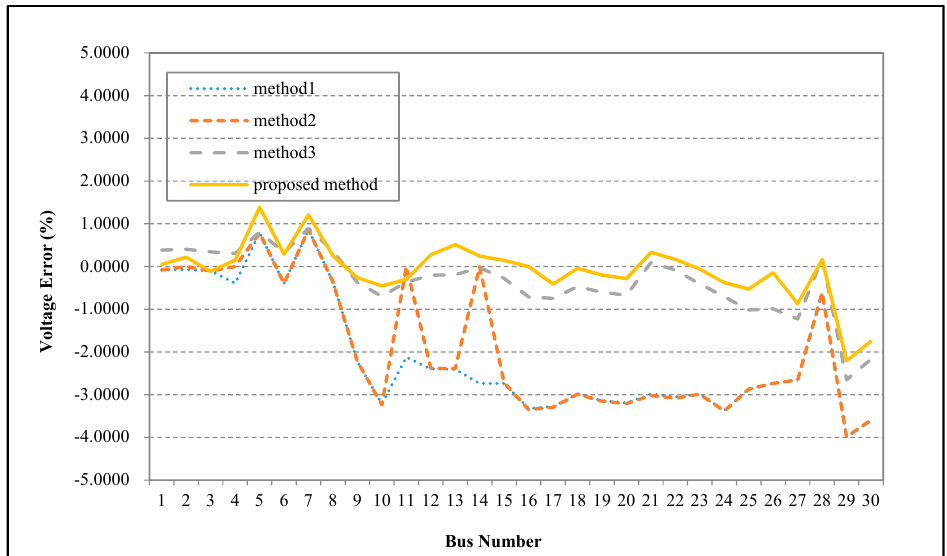
Figure 14. The percentage of voltage amplitude estimate error in 30 bus system.